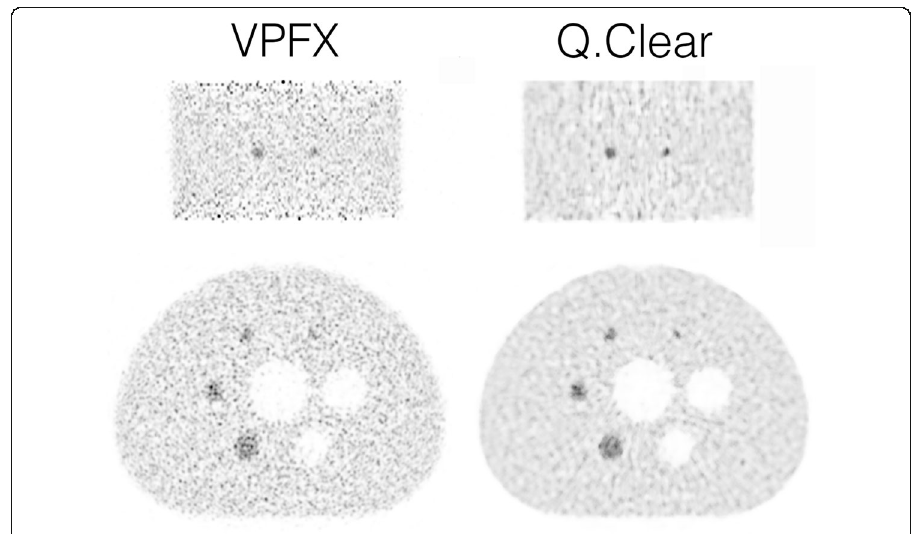
Fig. 6 Image quality phantom images. Left images are obtained by VPFX reconstruction, right images by Q.Clear reconstruction with beta = 50. The top row represents coronal slices through 10-mm and 13-mm spheres, the bottom row axial slices through all